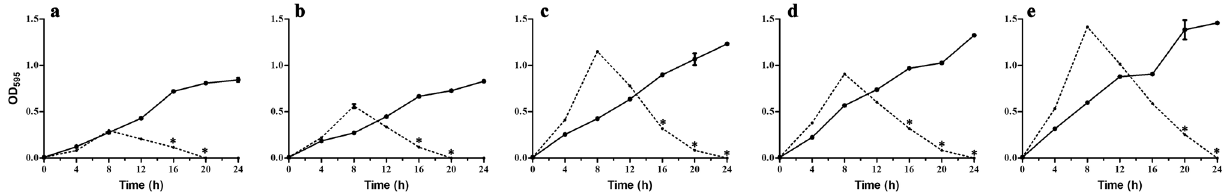
Figure 5. Survival curve of some uropathogenic isolates in the presence of Acacia nilotica aqueous extract. Shown are the median OD 595 values of Escherichia coli ( a ); Klebsiella pneumoniae ( b ); Proteus mirabilis ( c ); Pseudomonas aeuroginosa ( d ); and Acinetobacter baumanii ( e ) in TSB media (solid line) or supplemented with MBC value of Acacia nilotica aqueous extract (dashed line) for each isolate at 37 °C. Shown are the medians from at least three independent measurements. The error bars indicate the interquartile range. Significant differences between the data sets are marked by asterisks ( P < 0.05; Kruskal–Wallis test and post hoc Dunn’s multiple